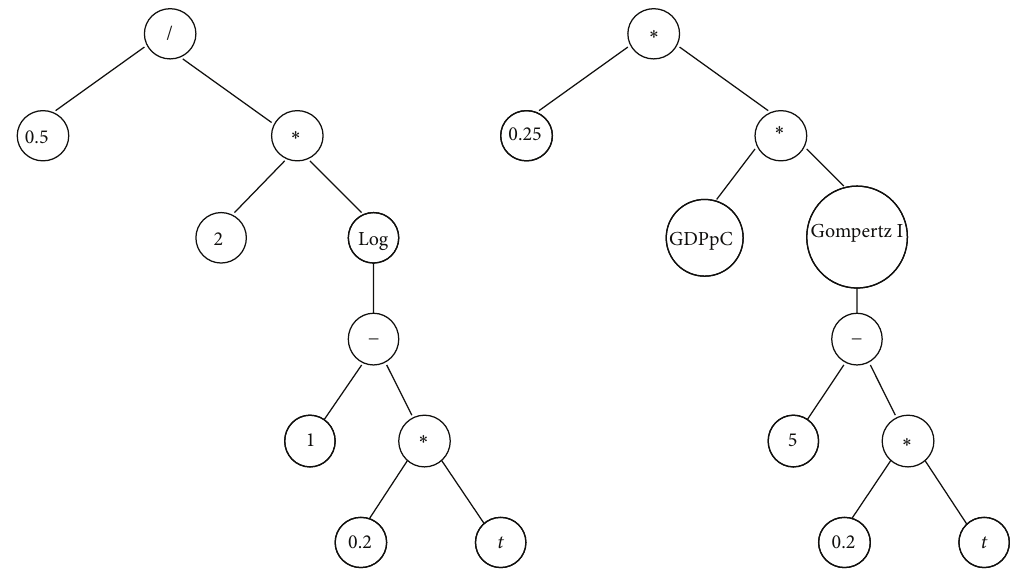
Figure 3: Representation of chromosomes in modified hGP as parse